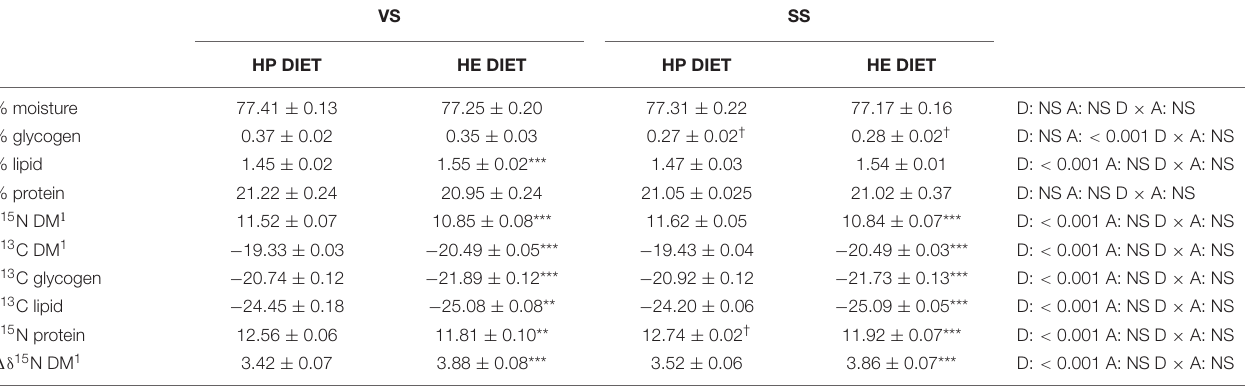
TABLE 4 | Proximal composition and stable isotopes analysis in skeletal white muscle. VS SS HP DIET HE